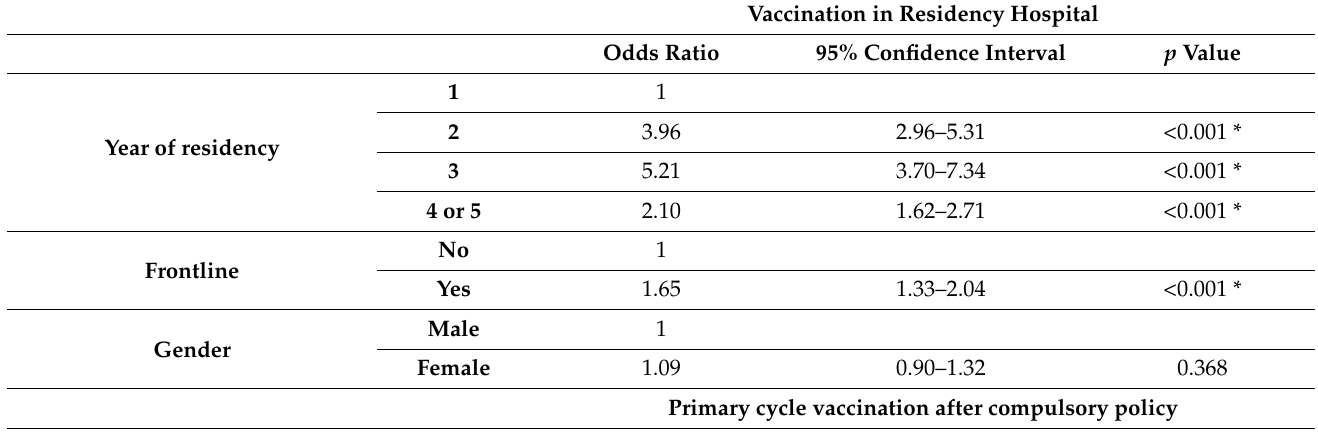
Table 4. Logistic regression models for vaccination in residency hospital, primary vaccination before compulsory policy, and booster dose before compulsory policy (* p < 0.05, statistically significant). Vaccination in Residency